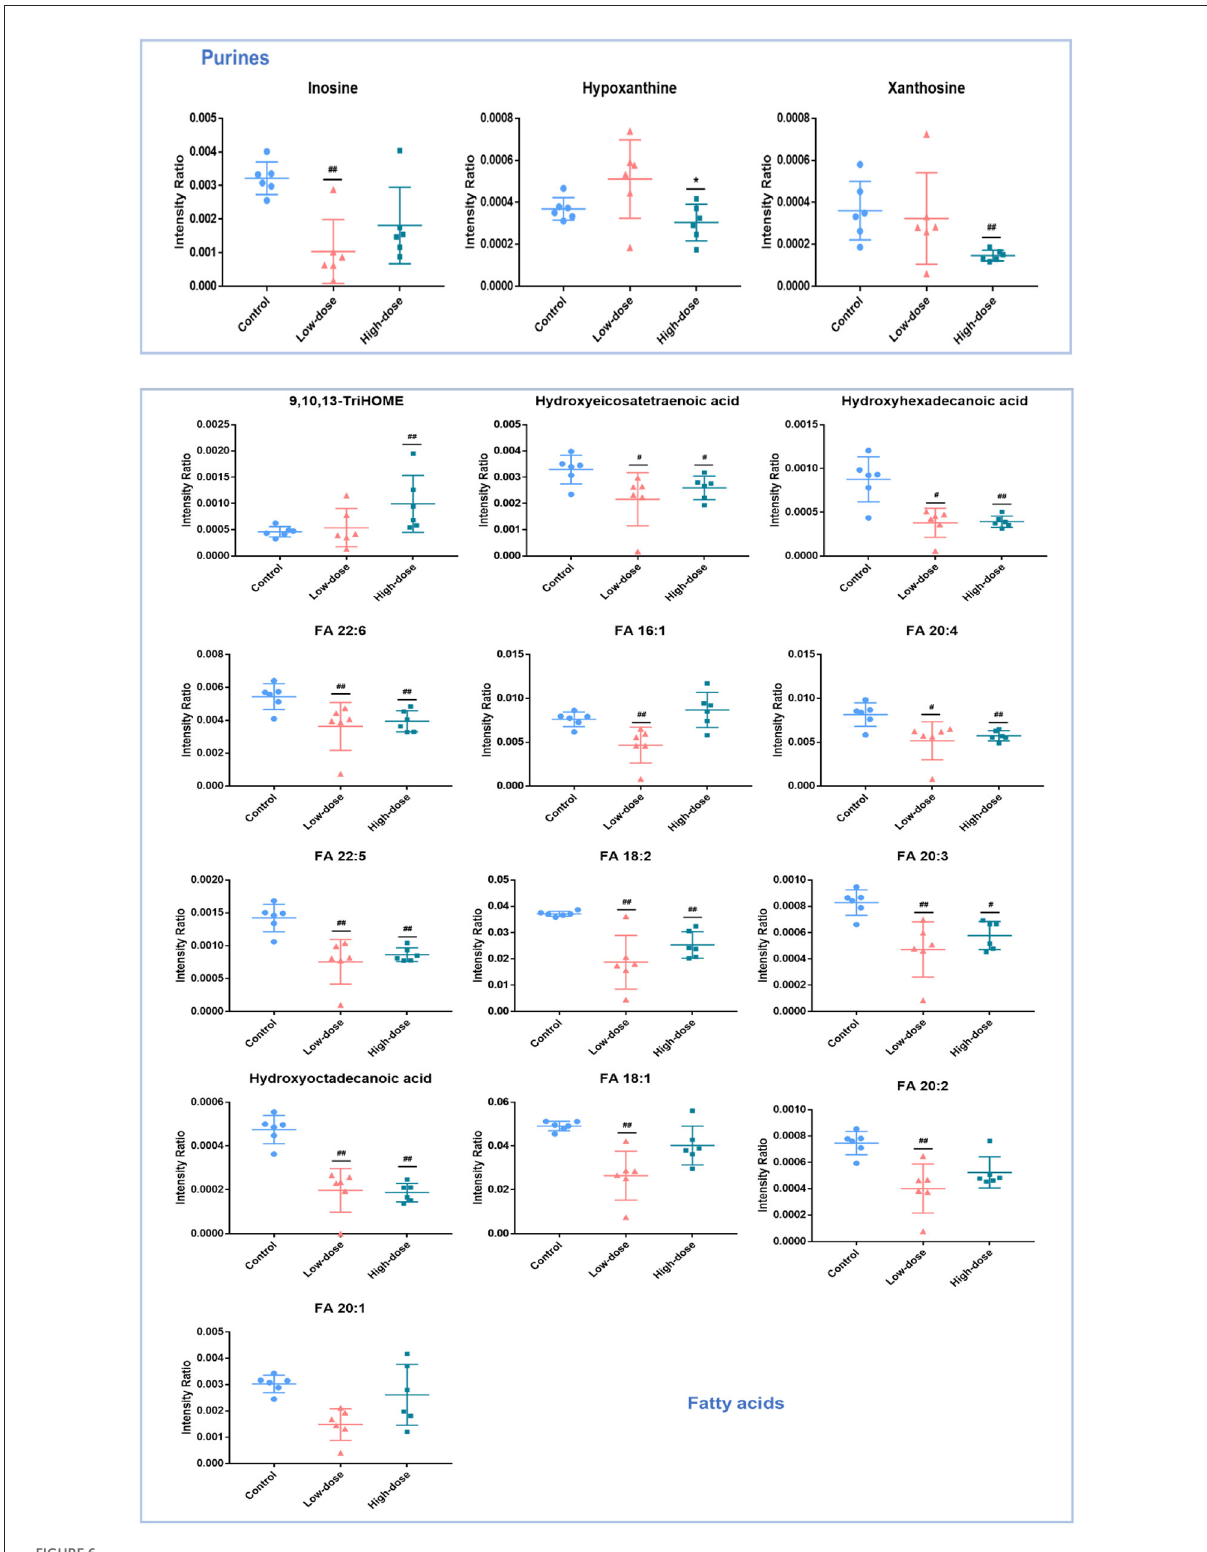
FIGURE6 Comparison of three groups of differential metabolites with scatter box